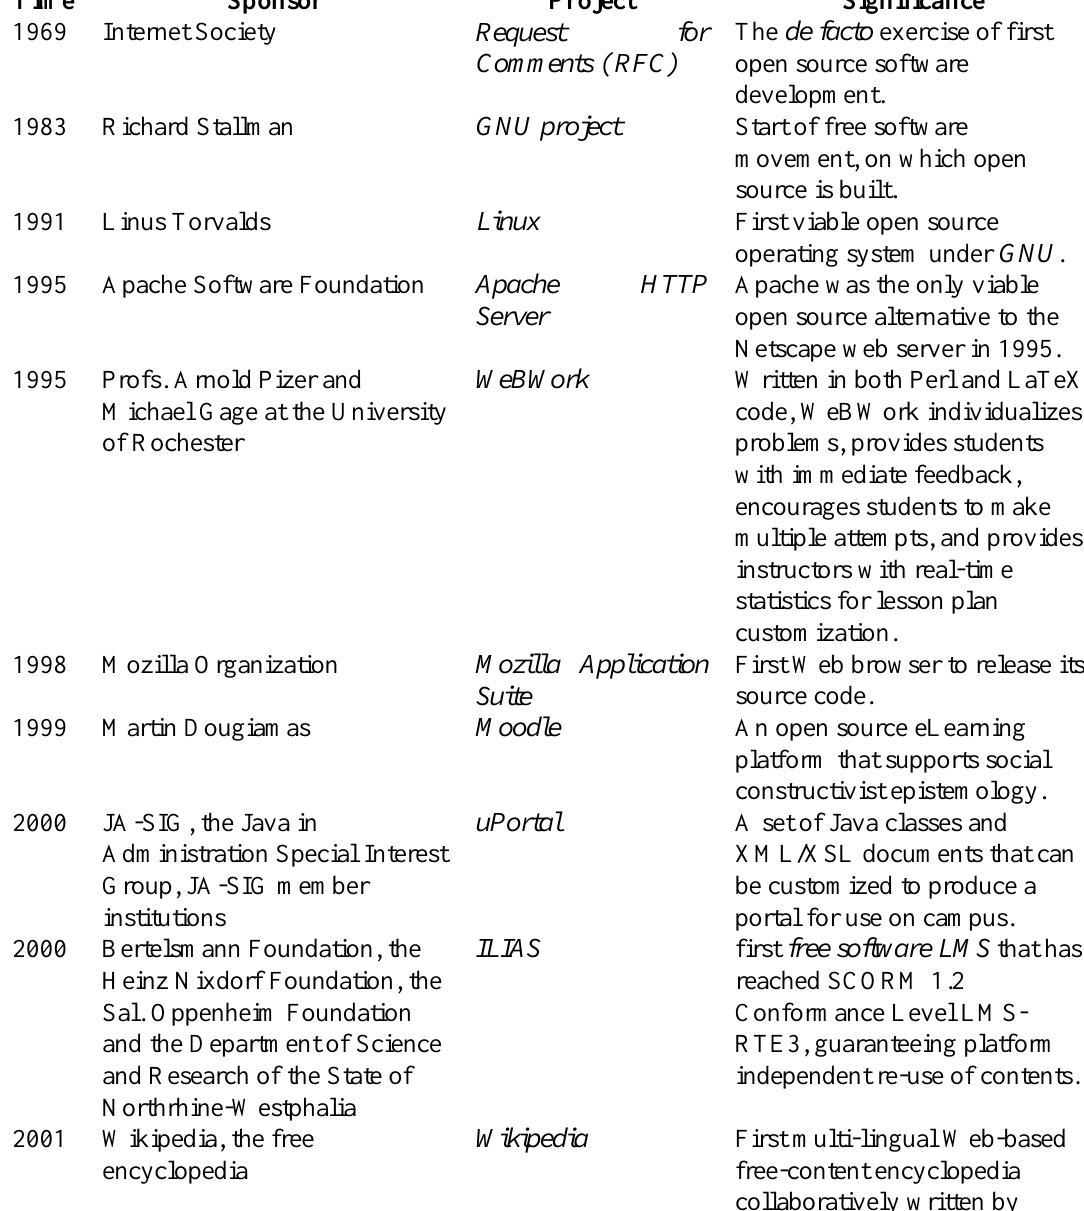
Table 2. Important Open Source Projects in North